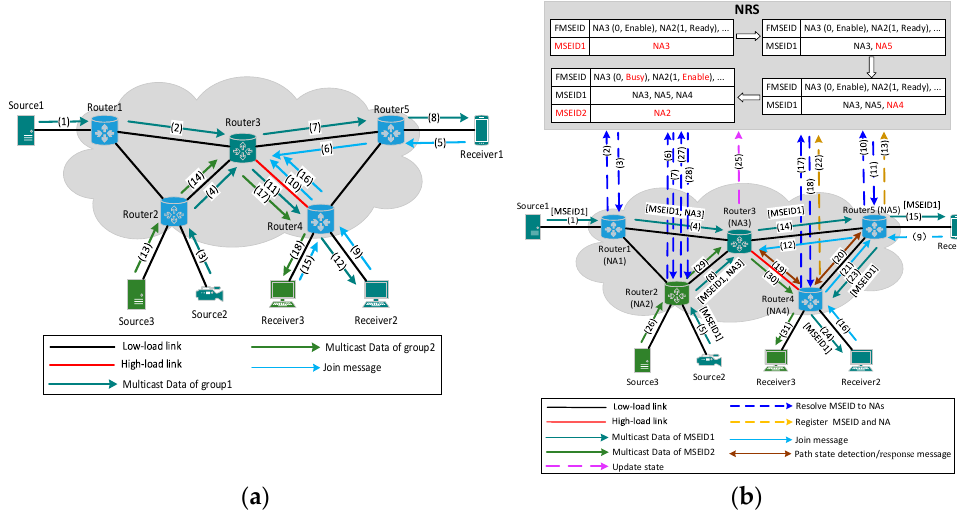
Figure 5. The use-cases of PIM-SM and ILDM. ( a ) The use-case of PIM-SM; ( b ) the use case of ILDM.